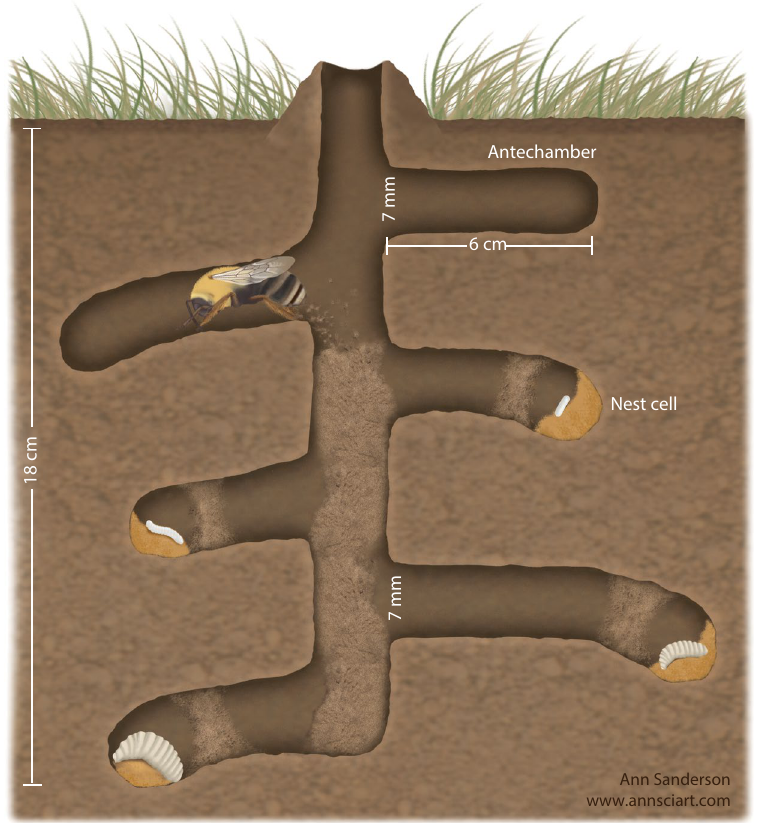
Figure 1. Nest of a hoary squash bee ( Peponapis pruinosa ) showing an adult female excavating a lateral tunnel and four immature stages (larvae) in sealed nest cells. Each nest cell is coated with a water-resistant lining. Soil from the main vertical tunnel is moved to the soil surface and soil from lateral tunnels is backfilled into the vertical tunnel. The length of lateral tunnels varies. Graphic designed by D. Susan Willis Chan, drawn by Ann Sanderson and reproduced with